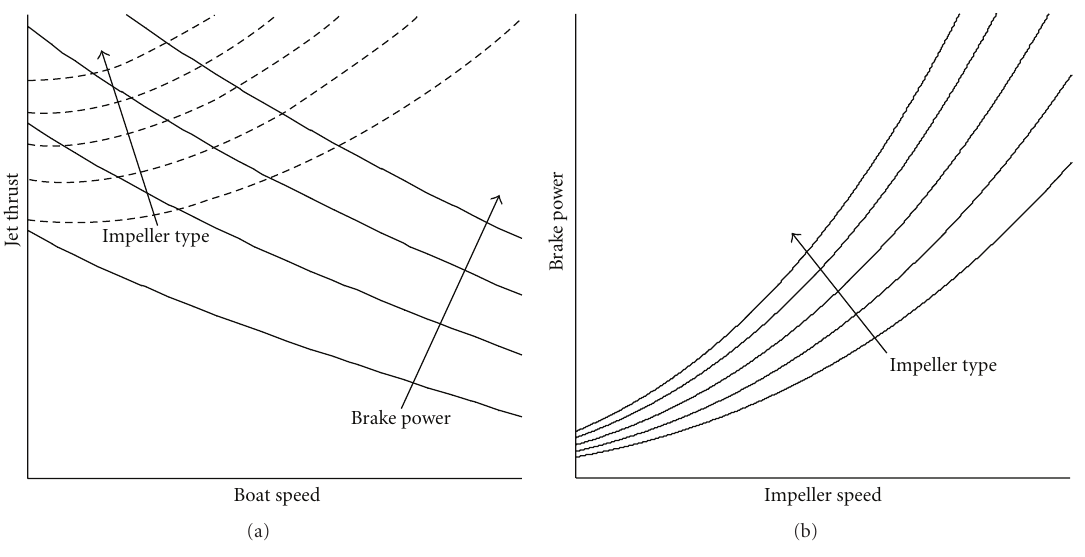
Figure 2: Typical jet curves (“Hamilton Jet”